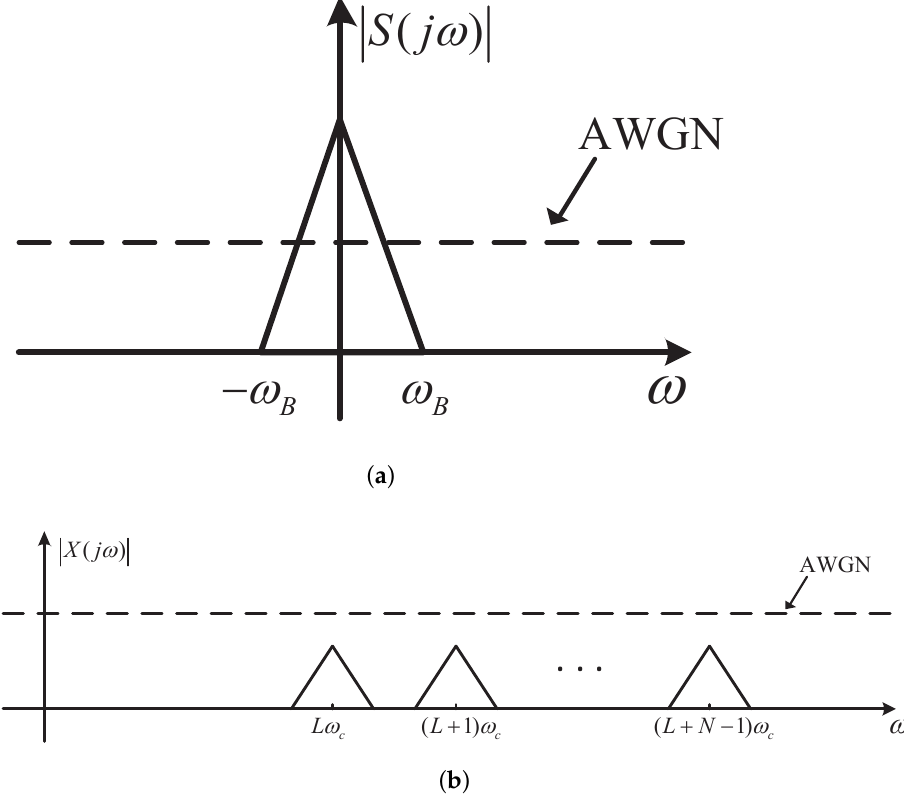
Figure 1. Comparison diagram of the spectrum between s ( t ) and x ( t ) . ( a ) Spectrum of modulated signal s ( t ) . ( b ) Spectrum of the proposed LPD signal x ( t )